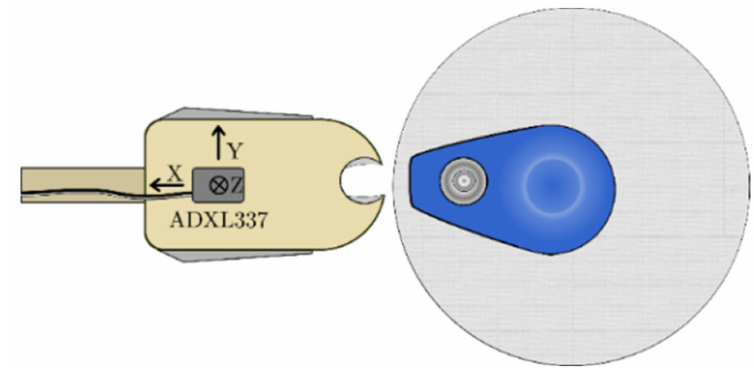
Figure 8. Disposable electrode and clip with the